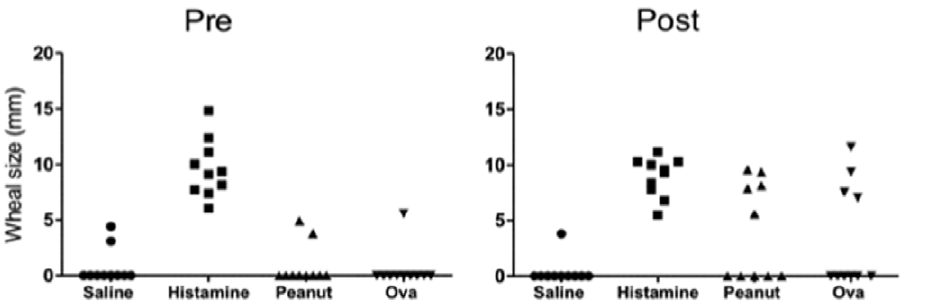
Figure 4. Skin wheal responses before and after allergen sensitisation. Mean wheal reaction size measured at 30 minutes post injection in Study 1 (n=10). Saline alone served as a negative and histamine as a positive